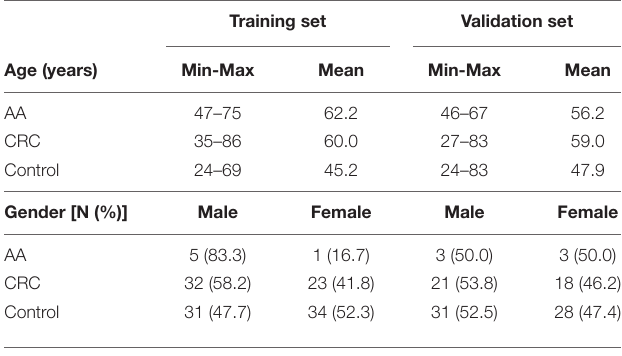
TABLE 2 | Positive detection rates of m SEPT9 and m SDC2 with 1/3, 2/3, and 3/3 algorithms for AA, CRC, and control groups. Algorithm Group Subject number (n) Positive detection rate (95% CI:%)